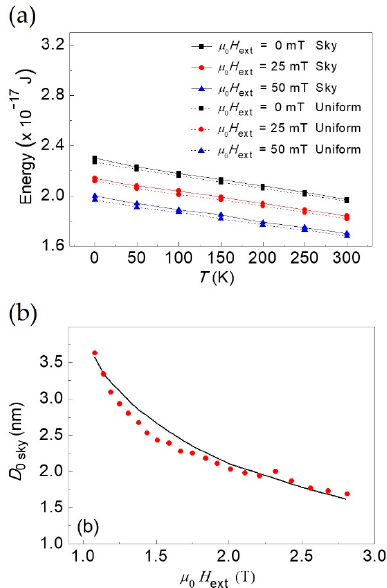
Figure 3. ( a ) Skyrmion state energy minimum compared to uniform state energy minimum for μ 0 H ext = 0 mT and in the presence of an external field of amplitude μ 0 H ext = 25 mT and μ 0 H ext = 50 mT, respectively. Continuous lines: skyrmion energy minimum vs. T . Dashed lines: corresponding energy of the uniform state for the same external bias field amplitudes; ( b ) Equilibrium skyrmion diameter vs. the external bias field. Continuous black line: analytical calculation from the minimization of the skyrmion energy. Red circles: experimental data obtained with spin ‐ polarized scanning tunnel microscopy [48] at T = 4.2 K.